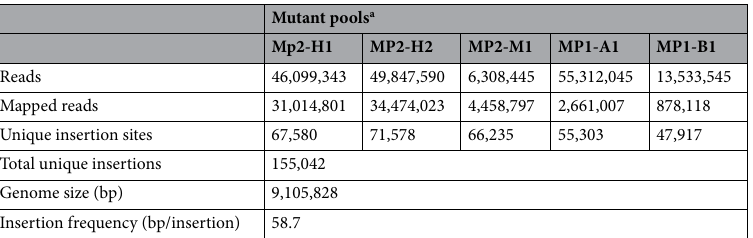
Table 1. Bd110 spc4 transposon library composition. a Technical replicates of Master mutant pool 2 (Mp2-H1, Mp2-H2 and MP2-M1) and Master mutant pool 1 (MP1-A1 and MP1-B1) were prepared and sequenced. Reads were mapped to the B. diazoefficiens strain USDA110 as a reference